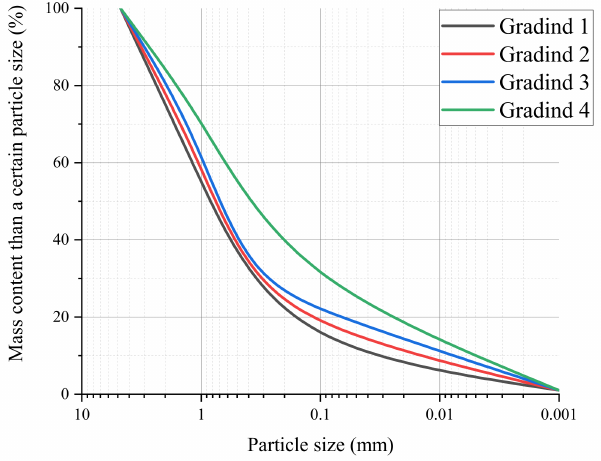
Figure 4. Particle size grading curve.